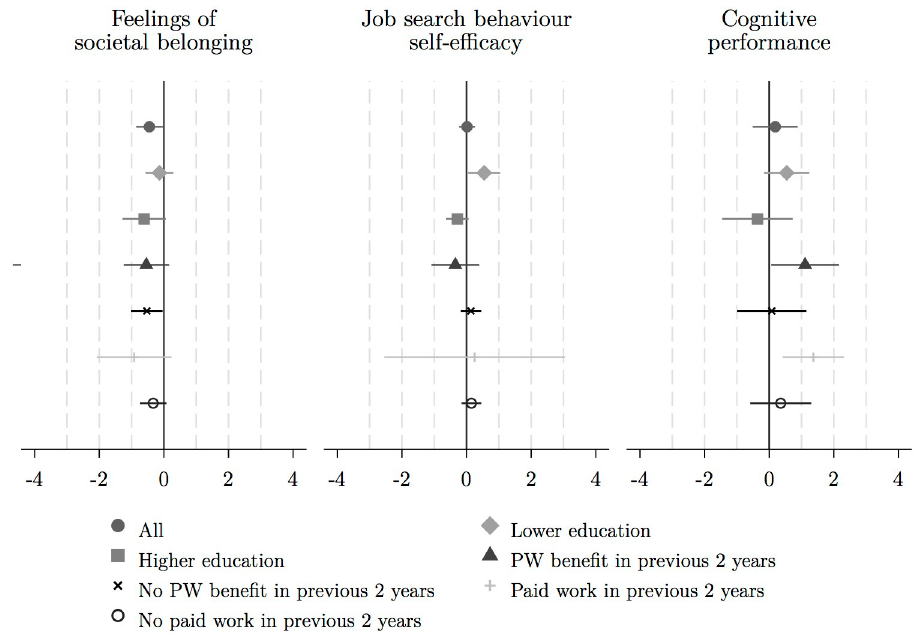
Fig 4. OLS estimation results, full sample and by subgroups: Feelings of societal belonging, job search behaviour self-efficacy and cognitive performance. Source : See Fig 3.